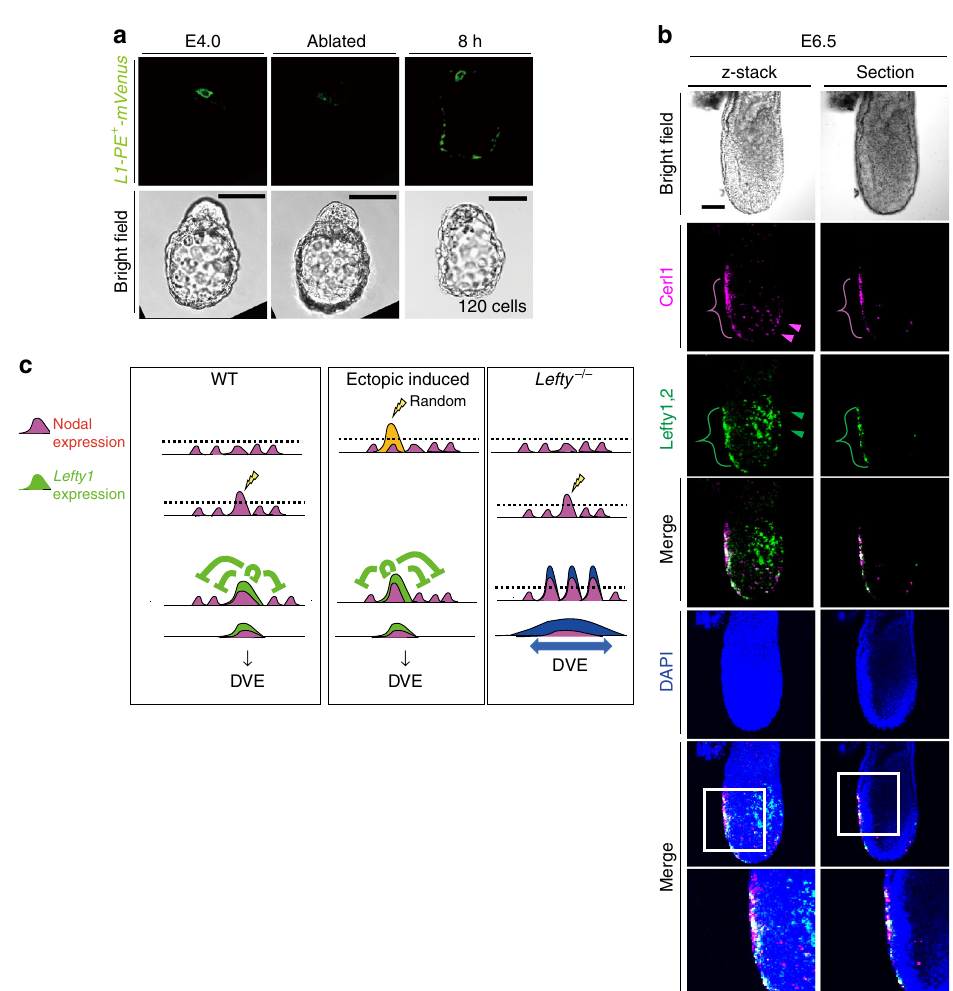
Fig. 7 Ablation of L1 dve cells at E4.0 results in the appearance of new L1 dve cells and does not impair A – P patterning. a All mVenus + cells (L1 dve cells) were removed by laser ablation from an E4.0 embryo harboring an L1-PE + -mVenus transgene (Fig. 1b), after which the embryo was cultured for 8 h and then subjected to immuno fl uorescence staining for mVenus. Note that a new mVenus + cell had appeared by 8 h after the ablation. Scale bars, 50 μ m. b After culture, an embryo such as that in a was transferred to a pseudopregnant mouse, allowed to develop until E6.5, and then recovered for immuno fl uorescence staining of A – P markers. Lefty1 and Cerl1 were detected in the AVE, suggesting that a normal A – P axis was established. Arrowheads indicate Cerl1 + de fi nitive endoderm cells in magenta, and Lefty2 + de fi nitive ectoderm cells in green. The boxed regions of the merged images are shown at higher magni fi cation in the images immediately below. c Model for the spatial distribution of Nodal expression and Lefty1 expression in a peri-implantation embryo based on observations in the present study. In the WT embryo (left panel), a cell that fi rst expresses Nodal beyond a threshold level (dotted line) begins to express Lefty1 . The Lefty1 protein then produced rapidly represses Nodal signaling in nearby cells, preventing them from expressing Lefty1 . Injection of Nodal mRNA into a cell (middle panel) induces expression of Lefty1 . In the absence of Lefty (right panel), a larger number of cells manifest Nodal expression or activity beyond the threshold and are fated to become DVE. See text for further